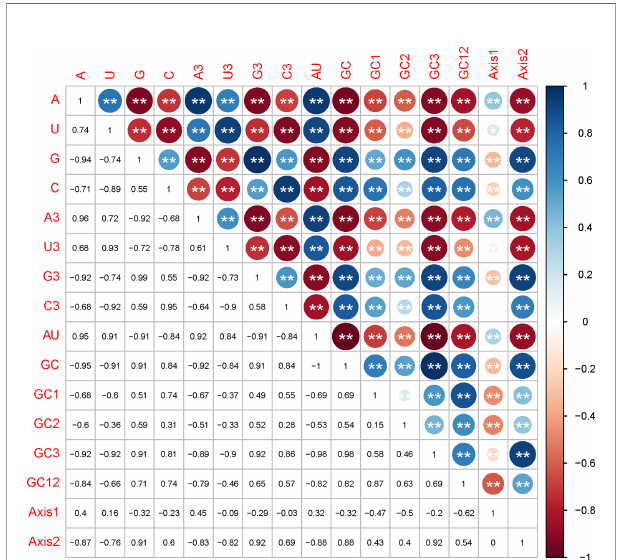
FIGURE 4 | Correlation analysis between nucleotide compositions and the two principal axes of COA plot. The numbers in lower triangle matrix show the slope of regression line. The upper triangle matrix shows the information by the color and size of circles; Dark blue means positive correlation and dark red means negative correlation; The bigger circle means more signi fi cant correlation; NS means non-signi fi cant (p > 0.05), * represents p < 0.05, ** represents p <